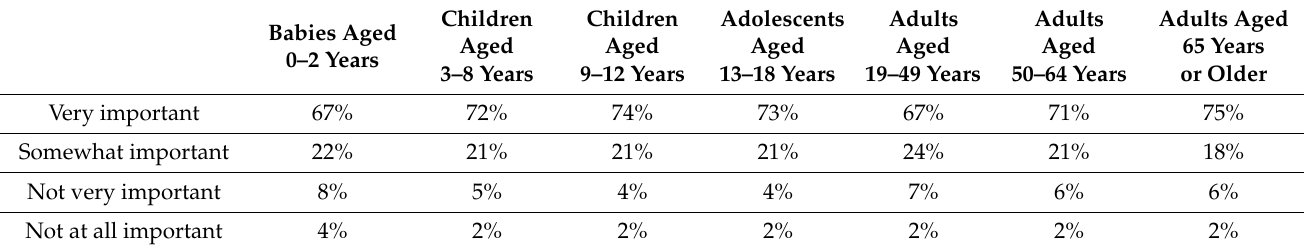
Table 1. Perceived importance of state vaccination programs per age group for all respondents without religious objections to vaccination (n =